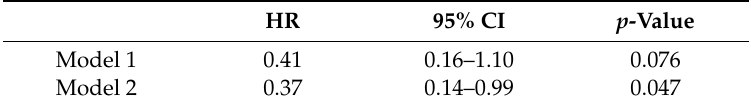
Table 3. Association of systemic body iron release with cardiovascular (CV) death during follow-up (maximum 6.7